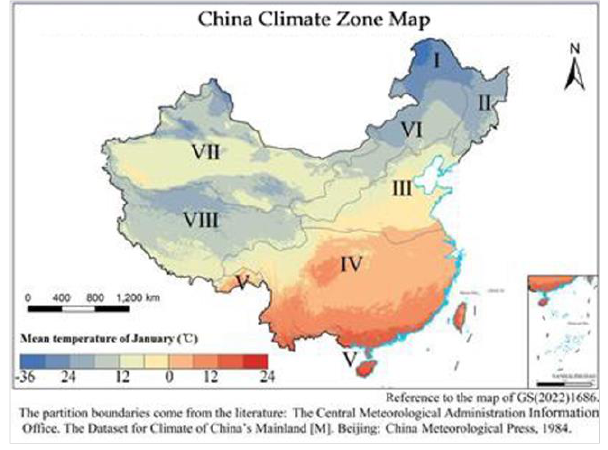
Figure 3. Diagram of China’s climate zone map (Source: 30-year average 1 km monthly climate element dataset for China).